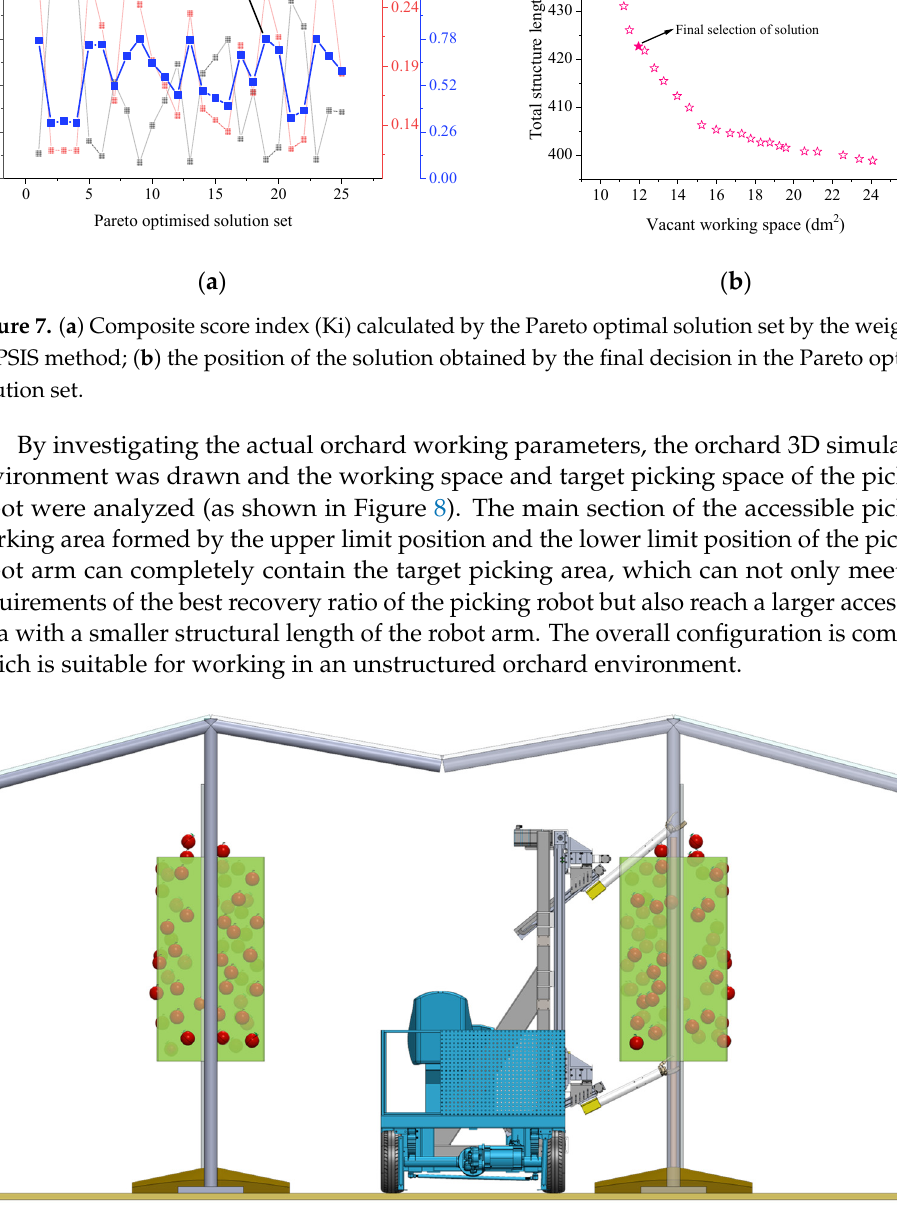
Figure 8. Optimization results of picking arm structure of dual-manipulator picking robot in orchard simulation environment.